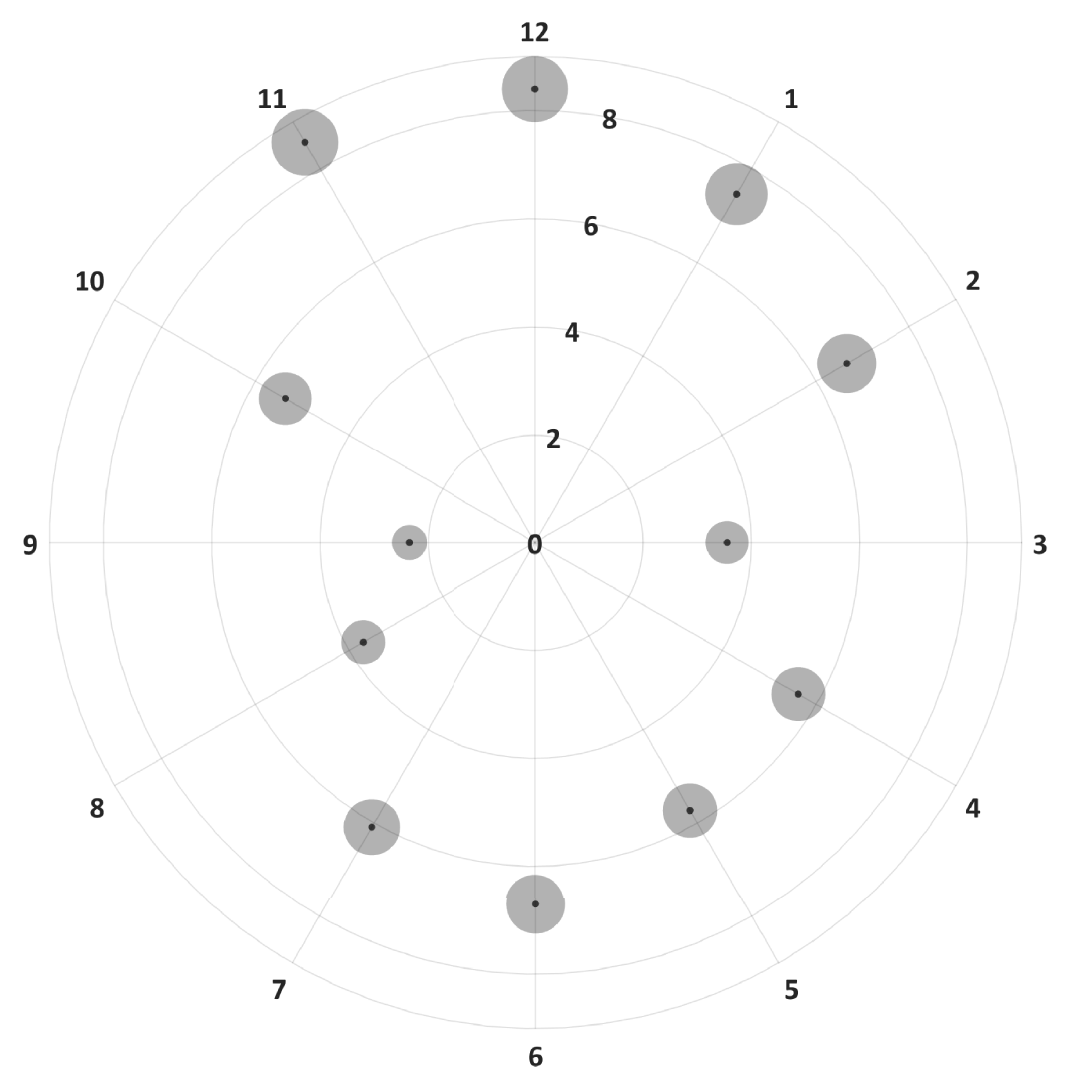
Fig 4. Intra-device repeatability for the inner limiting membrane to retinal nerve fiber layer thickness in different clock hour sectors for horizontal scans. The small black dots represent the within subject standard deviation and the grey circles surrounding each black point represent the repeatability limits, where the areas are scaled by a factor of 30 points for visualization purposes.